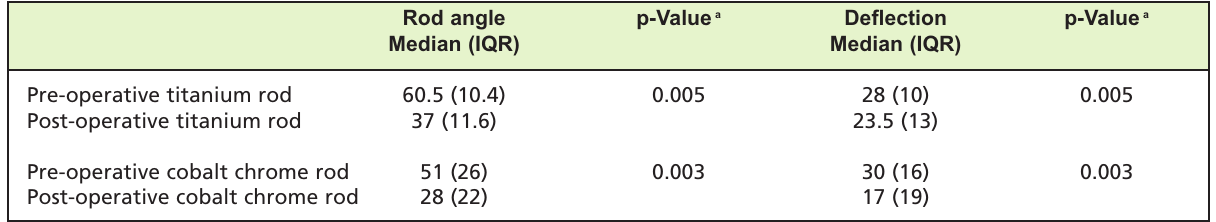
Comparison of rod deformation before and after implantation for titanium and cobalt chrome groups Table II: